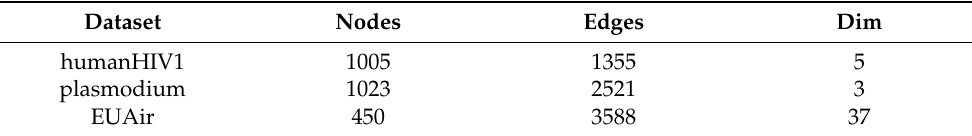
Table 6. Multigraph datasets description.